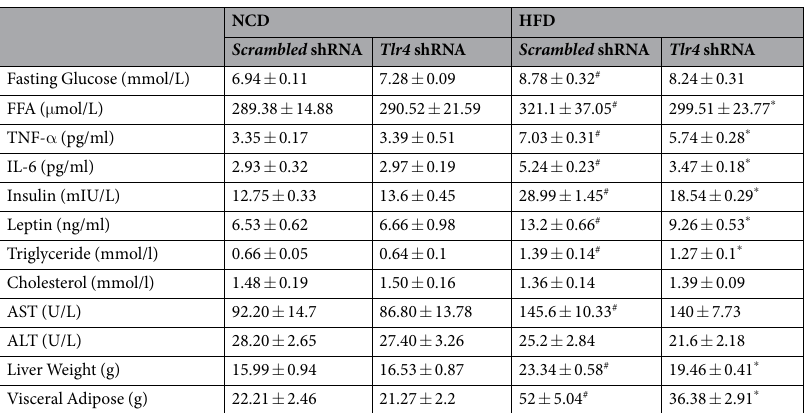
Table 2. Biochemical parameters of rats in the groups indicated at the 4th week after stereotaxical injection of Tlr4 shRNA or Scrambled shRNA lentiviral particles. Abbreviation: FFA, Free fatty acids; TNF- α , Tumor Necrosis Factor α ; IL-6, Interluekin-6; AST, Aspartate Aminotransferase; ALT, Alanine aminotransferase; NCD, Normal chow diet; HFD, High fat diet. All data in the table are shown as the mean ± S.E.M. (n = 7–8/group). * P < 0.05: HFD + Tlr4 shRNA group vs HFD + Scrambled shRNA; # P < 0.05: HFD group vs NCD group.